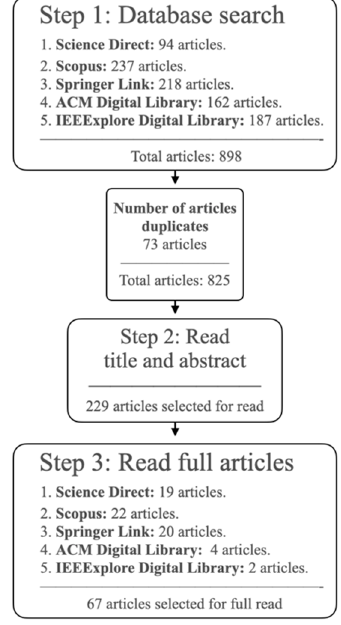
Figure 1. Diagram with the results of the article selection process.